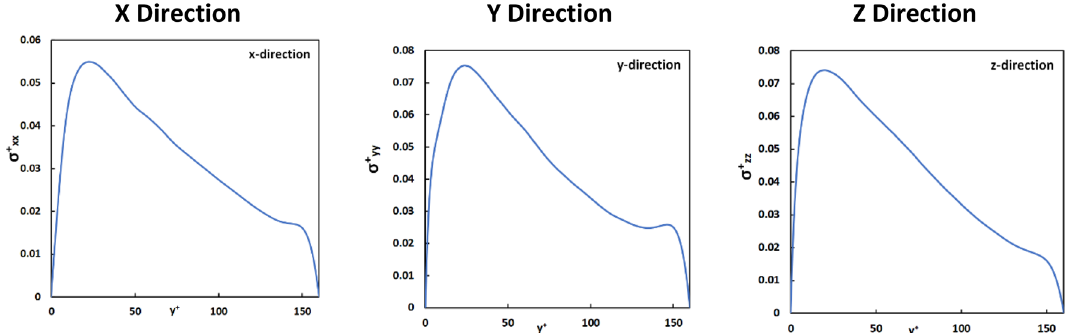
Figure 1. The magnitude of the extensional stress as a function of the channel height in the x , y , z directions in Poiseuille–Couette flow. These are averaged values of Eulerian velocity